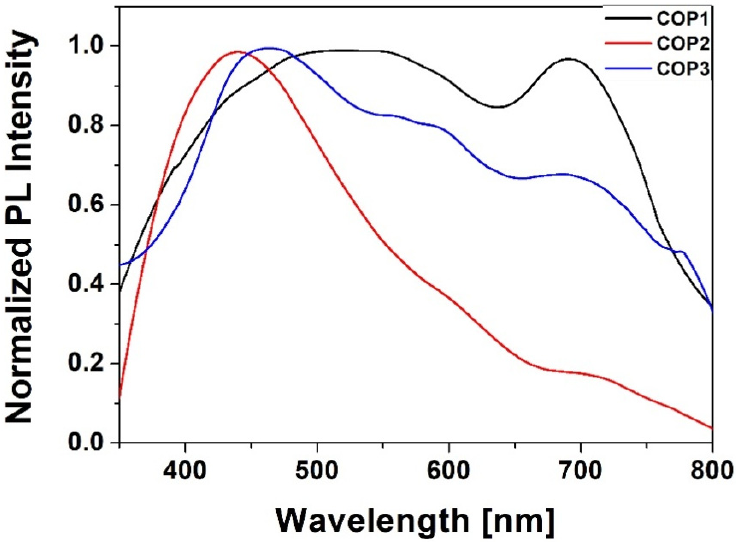
Figure 4. Photoluminescence spectra of styrylquinoline copolymers ( λ ex. = 266 nm).